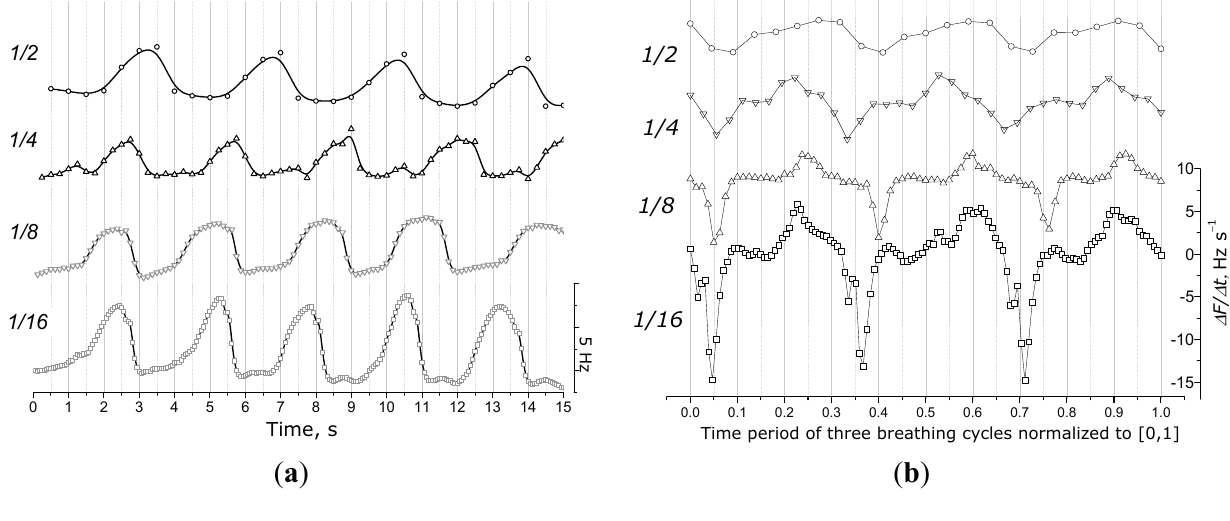
Figure 9. QCM frequency shifts and their derivatives in response to human respiration obtained at different sampling rates (  1/2 ,  1/4 ,  1/8 and  1/16 ). ( a ) Frequency shift response; ( b ) respective derivative signal (normalization performed to compare three breathing signals with different respiratory